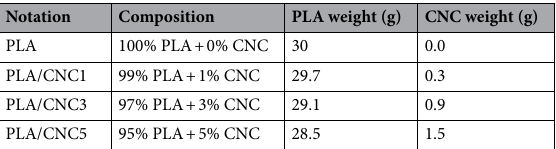
Table 3. Formulation of PLA/CNC